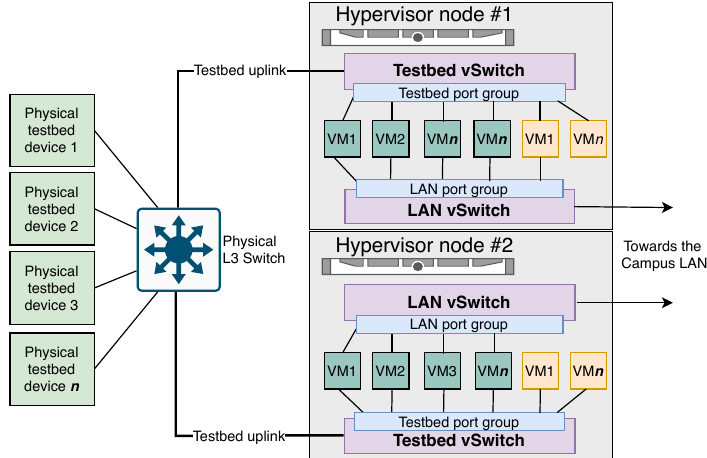
Figure 7. Cyber range environment physical infrastructure (green VMs used for students; yellow VMs support services and testbed components for the specific